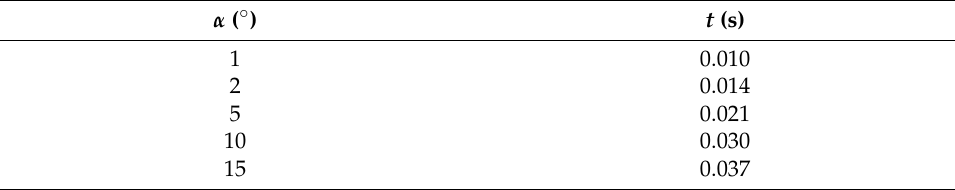
Table 2. Rotation time of the platform for selected angles.